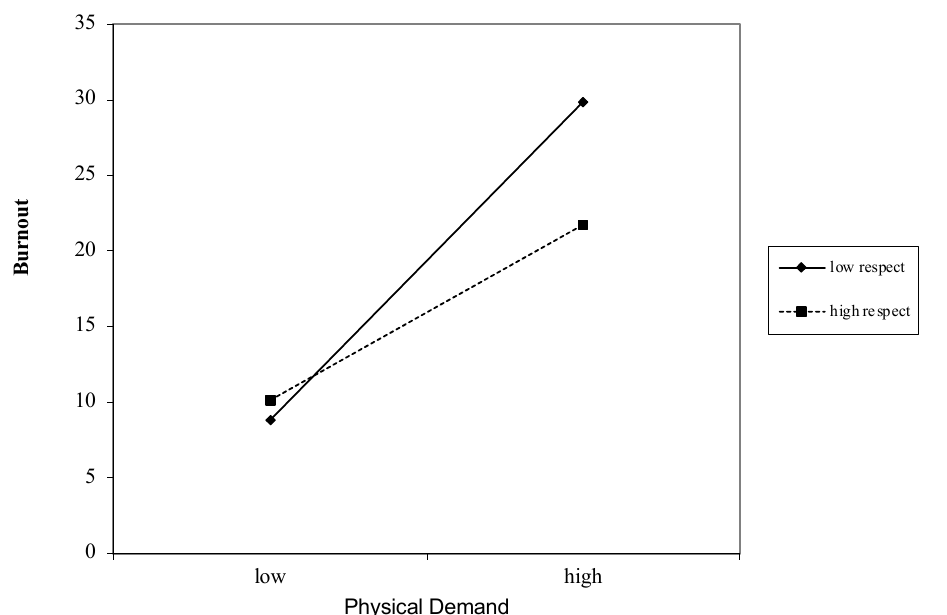
Figure 5. Graph of interaction plot between physical demands and respect. Perceived respect moderates the relationship between physical demand and burnout, such that those with low respect (1 SD below the mean) and high physical demand reported greater burnout.